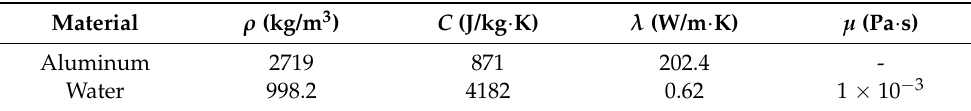
Figure 2. Topology optimization 2D design model. Table 1. Material